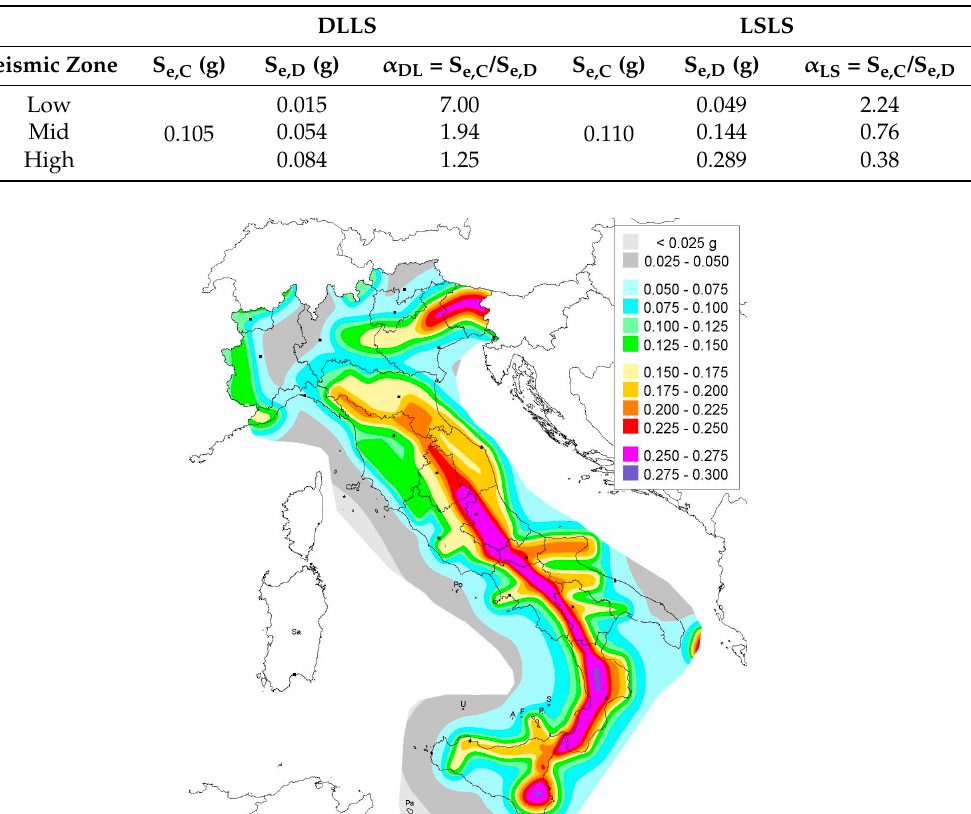
Table 3. Comparison between capacity and demand values, evaluated for both Damage Limitation (DLLS) and Life Safety (LSLS) for different seismic zones.